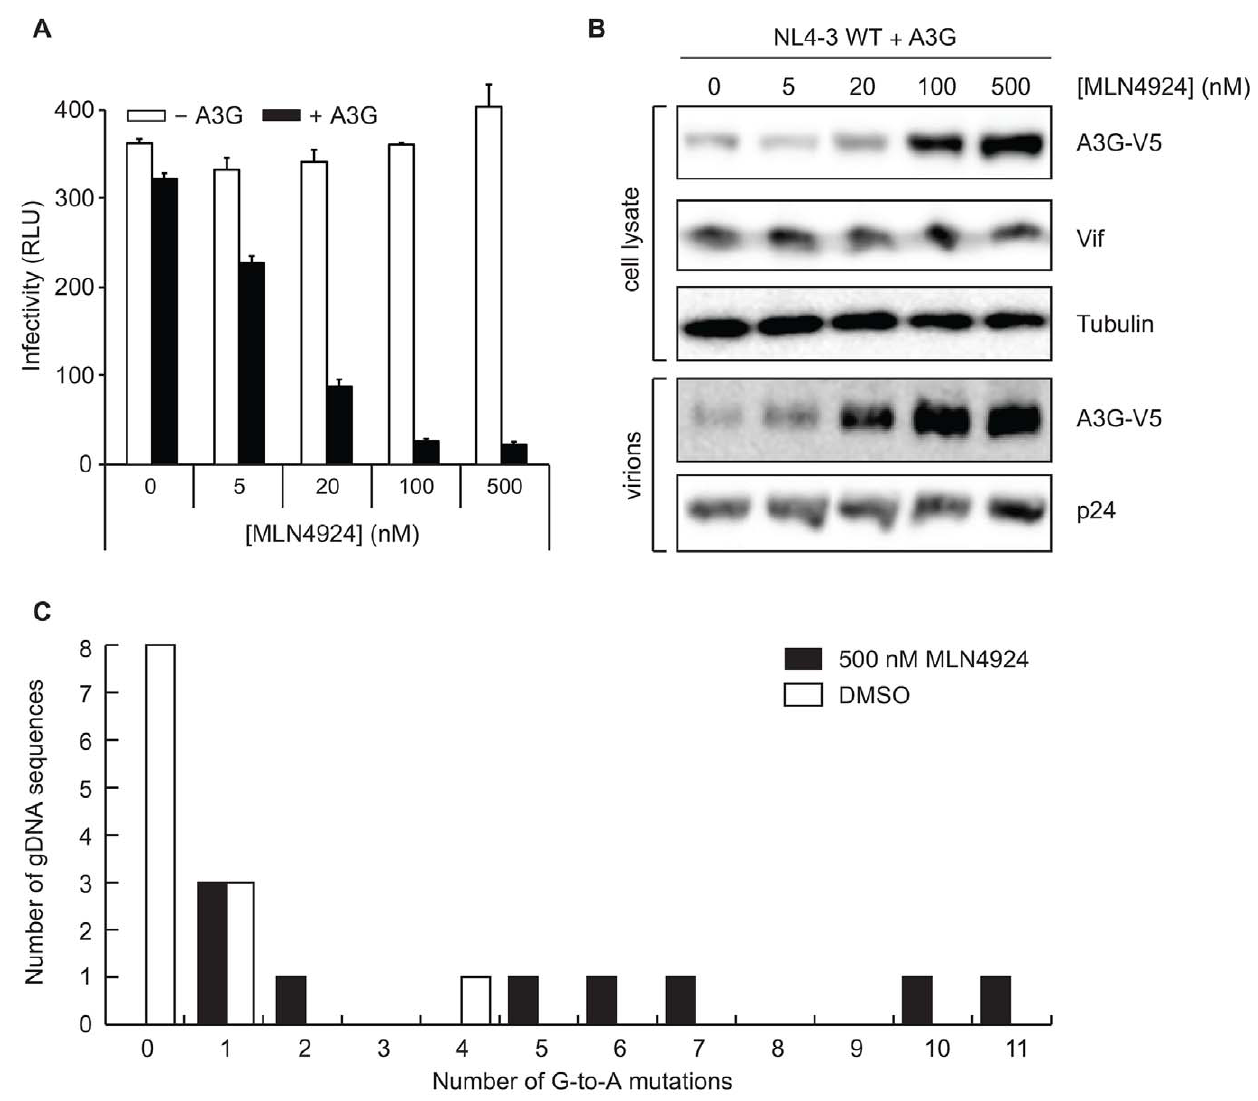
Figure 1. Pharmacological inhibition of NEDD8 E1 by MLN4924 blocks the ability of Vif to counteract A3G. A, Single-cycle infectivity assay of HIV NL4-3 produced in HEK293T cells transfected with empty vector control (white bars) or V5-tagged A3G (black bars, 120 ng) , 1 m g of NL4-3 proviral DNA and treated with indicated concentrations of MLN4924. B, Parallel immunoblots indicating MLN4924 restores steady-state levels of A3G in cells and packaging in virions. C, Quantitation of G to A mutations in gDNA sequences from virions produced in cells treated with either DMSO or 500 nM MLN4924.